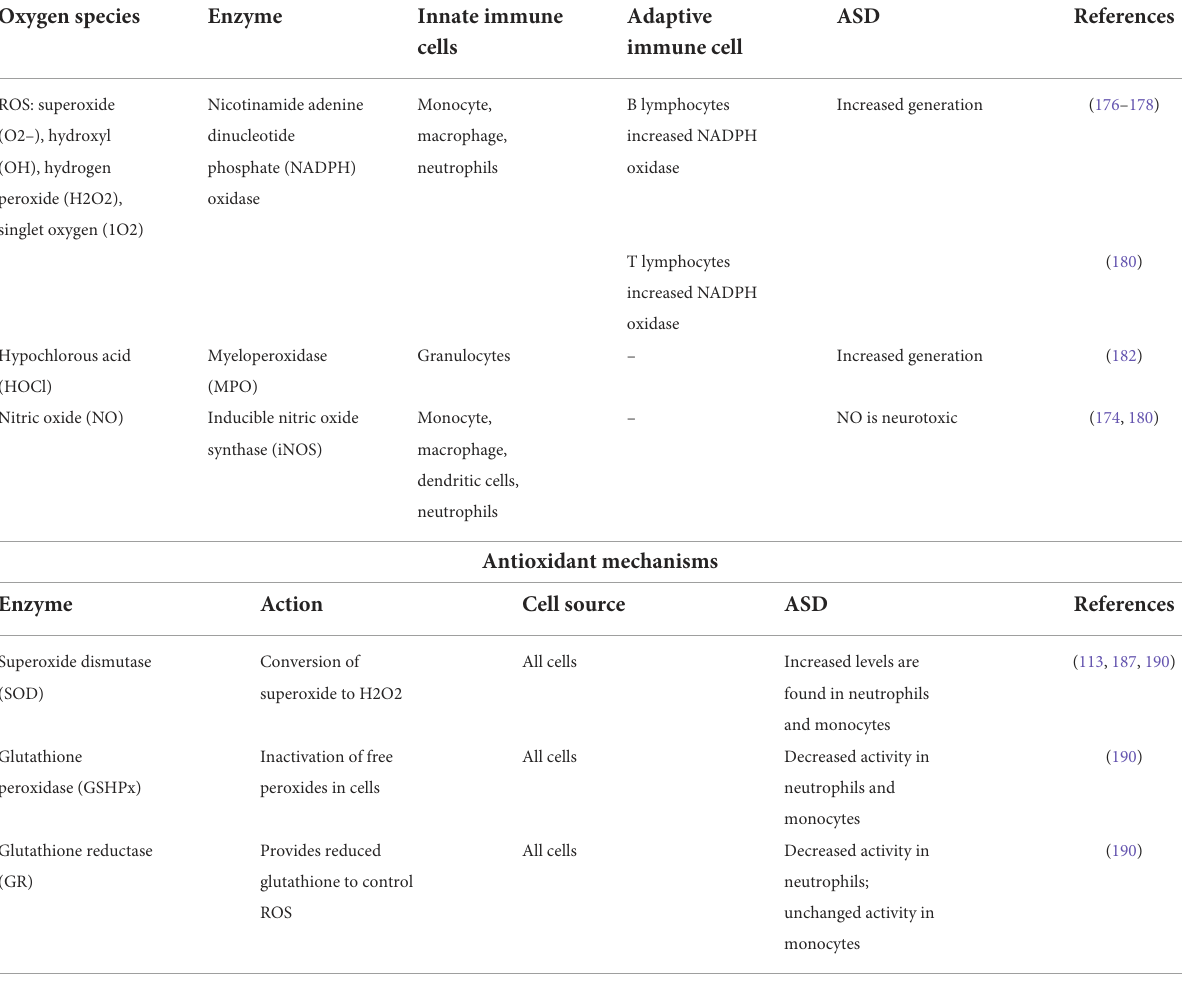
TABLE 1 Reactive oxygen species and anti-oxidants generated by immune cells in